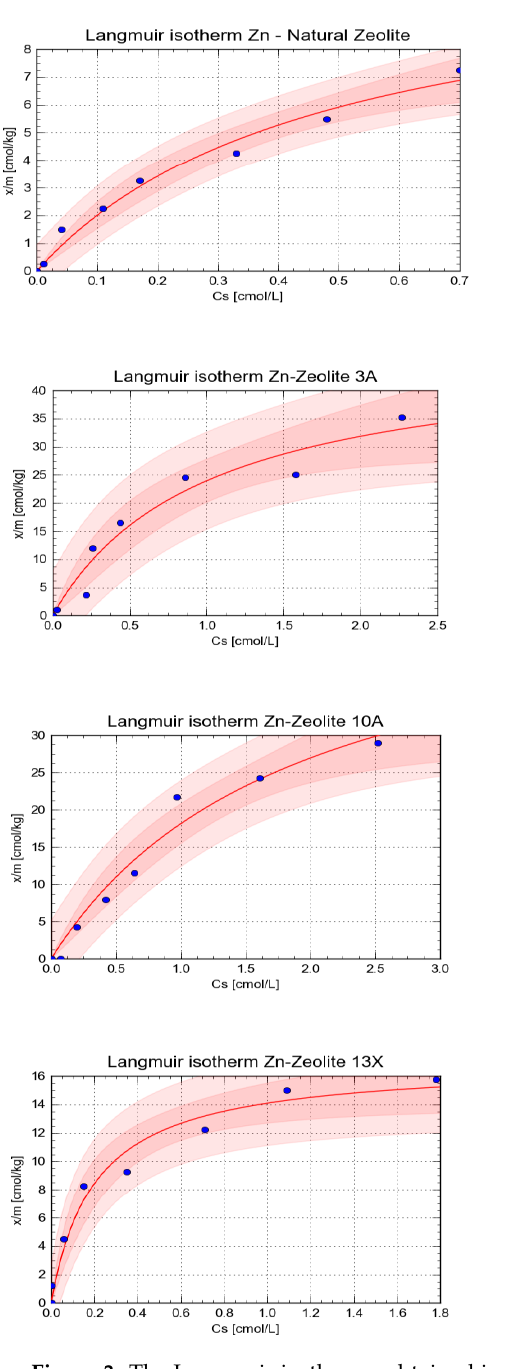
Figure 3. The Langmuir isotherms obtained in the study for sorption of Zn 2+ and Cd 2+ onto tested natural and synthetic zeolites.